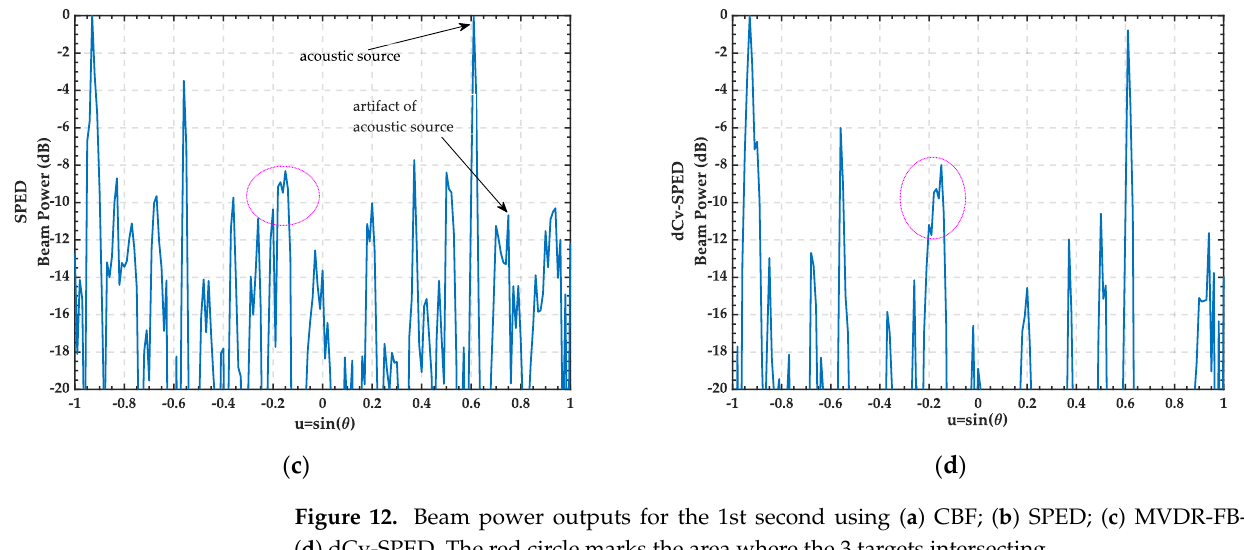
Figure 12. Beam power outputs for the 1st second using ( a ) CBF; ( b ) SPED; ( c ) MVDR-FB-FL; ( d ) dCv-SPED. The red circle marks the area where the 3 targets intersecting.